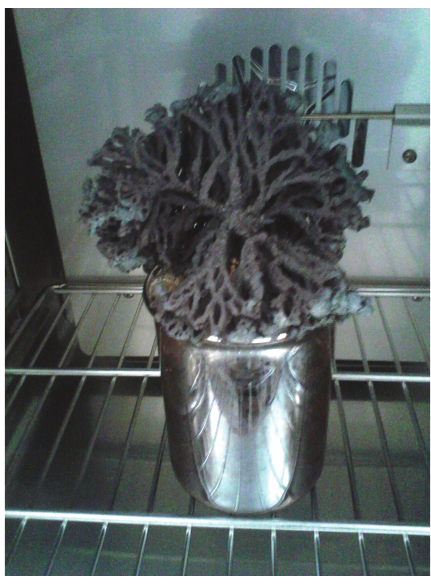
Figure 2: Photograph of Mn 0.8 Zn 0.2 Fe 2 O 4 ferrite after autocombus- tion process.